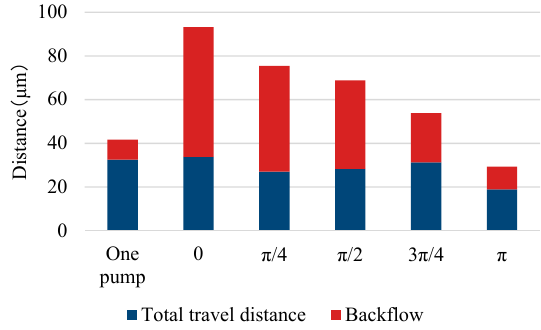
Figure 8. Forward flows and backflows of a parallel pump.